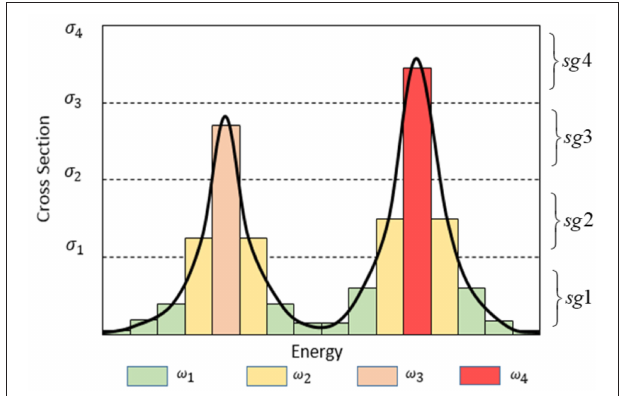
FIGURE 1 | Subgroup parameters in a resonance